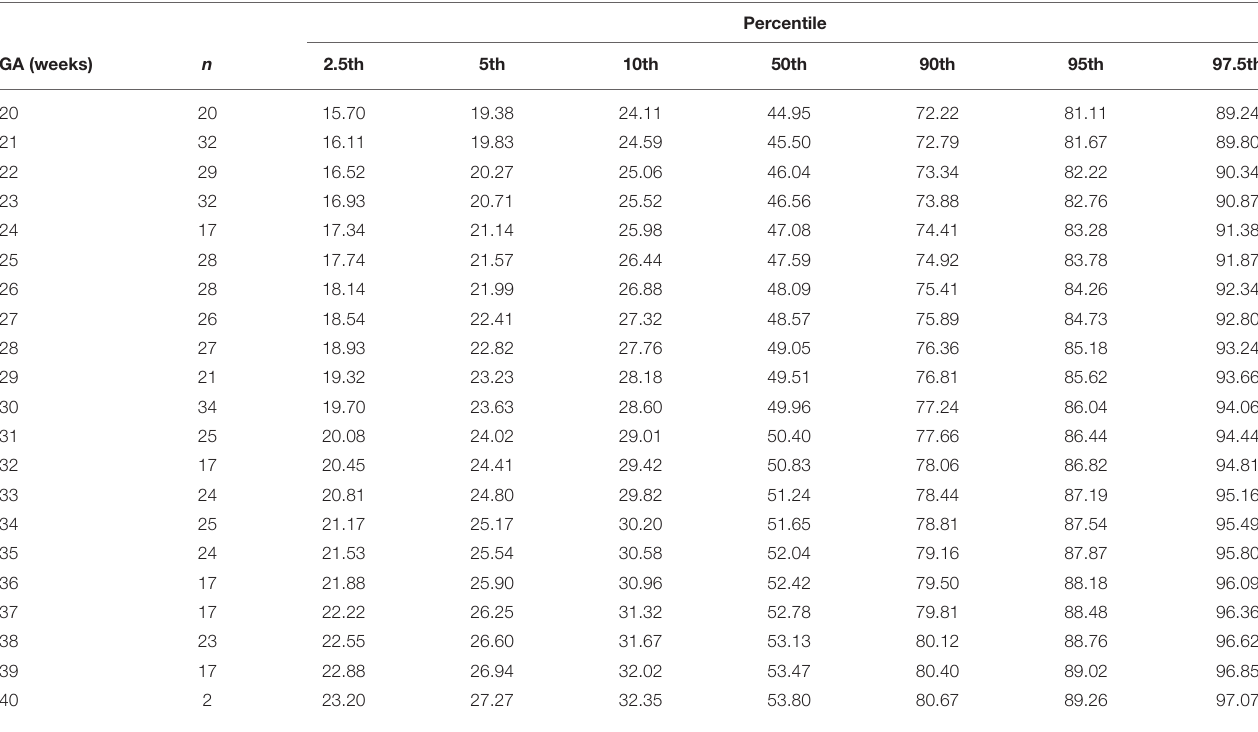
TABLE 4 | Percentiles of weight-indexed fetal superior vena cava volume blood flow (ml/min/kg) at 20-40 weeks of gestational age (GA).